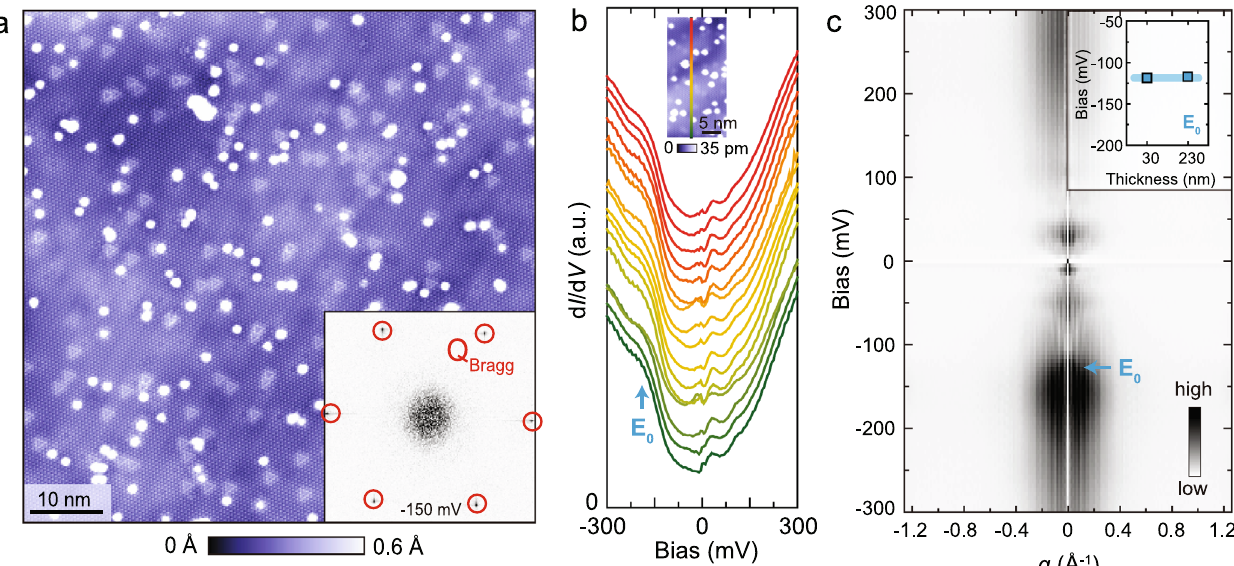
Fig. 2 Large-scale electronic structure. a Typical STM topograph of a large fl at region of the Fe 3 Sn surface. Inset in ( a ) shows Fourier transform of a normalized d I /d V ( r , V ) map ((d I /d V )/( I / V )) for bias V = − 150 mV. Atomic Bragg peaks related to the ab -plane lattice vectors are circled in red. b d I /d V linecut acquired over the vertical line denoted in the STM topograph in the inset. Blue arrow labeled as E 0 denotes an abrupt increase in conductance identi fi ed as a partial fl at band in ref. 28 c Radially averaged linecut generated from the FTs of normalized d I / d V ( r , V ) maps ((d I /d V )/( I / V )). E 0 denotes the energy below which the magnitude of the QPI wave vector is notably enhanced, concomitant with the increase in conductance in ( b ). Inset in c shows experimentally determined E 0 for two fi lm thicknesses extracted from the equivalent radially averaged linecuts as shown in c . STM setup conditions: a I set = 96 pA, V sample = 12 mV; inset in a – c I set = 1 nA, V sample = 300 mV, = 5 V exc